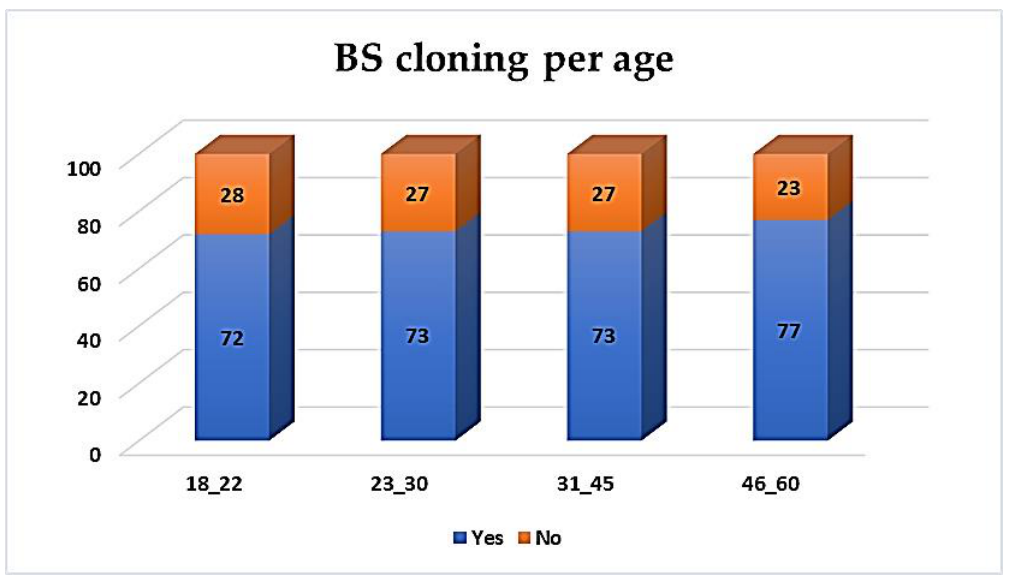
Figure 24. BS cloning per age .